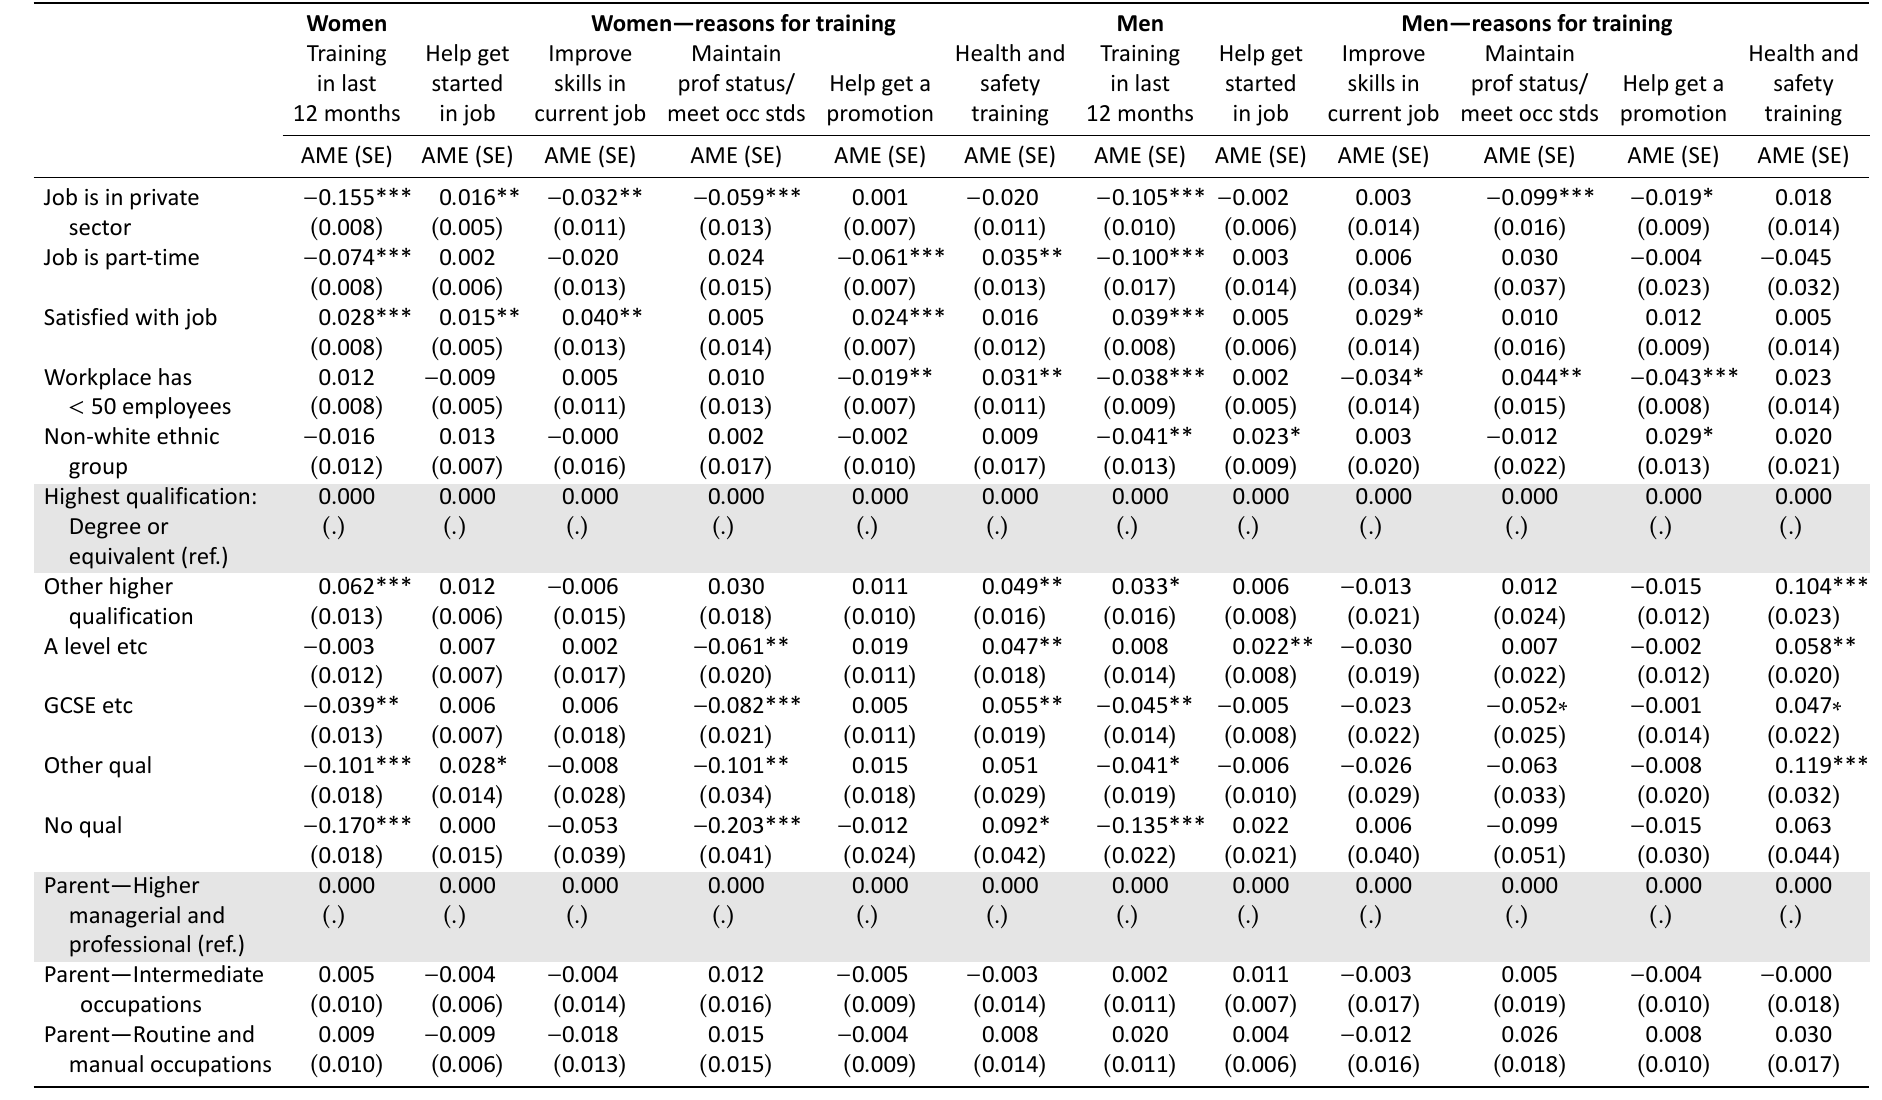
Table A4. (Cont.) Regression results, probability of participation in training in last 12 months, overall and by reason for training, men and women, pooled